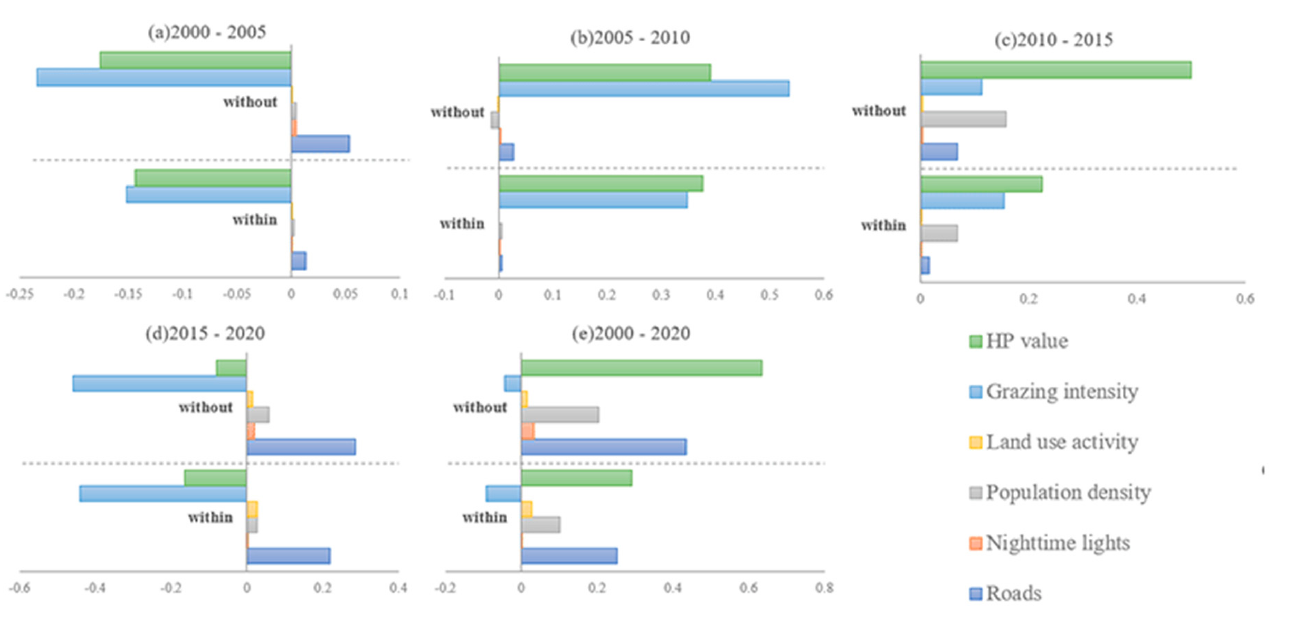
Figure 5. Changes in HP values inside and outside the NRs of the Qinghai–Tibet Plateau for 2000– 2020.